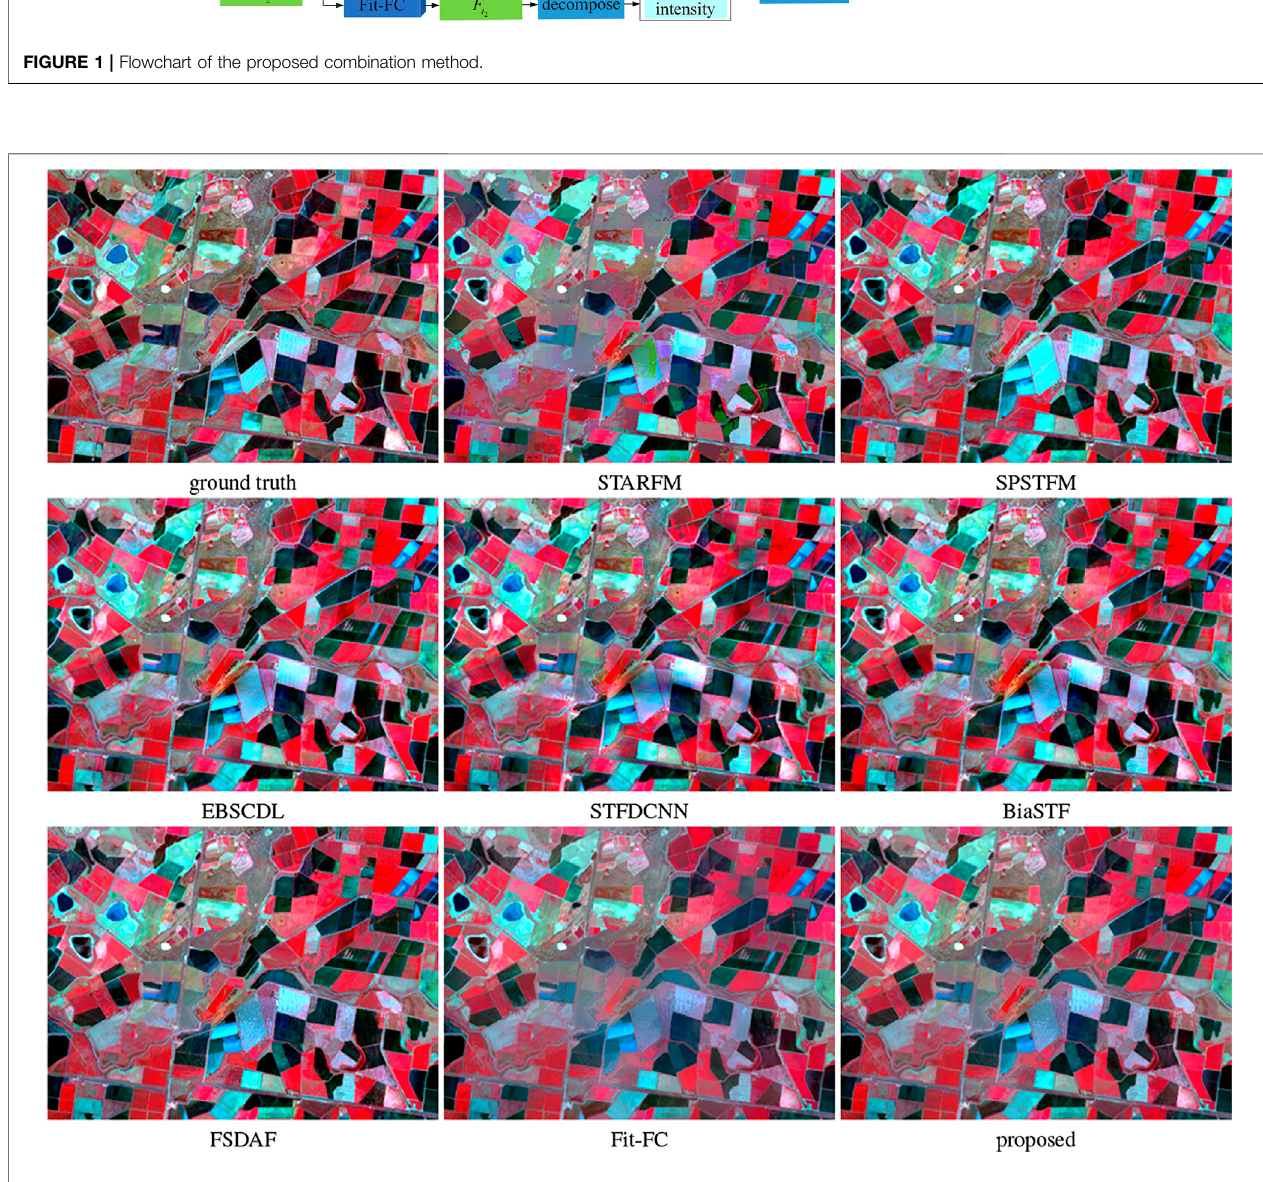
FIGURE 2 | Manifestation of the small region of the NIR, red, and green bands of CIA image 1 for detail observation.